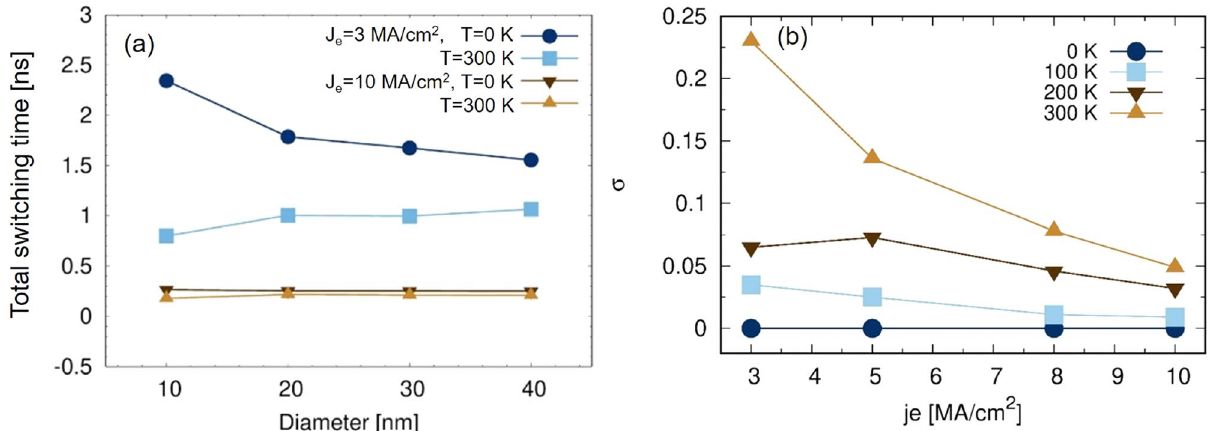
Figure 8. ( a ) Effect of finite size and temperature on the total switching time of magnetization in the free layer of CoFeB–MgO–CoFeB system by injecting the charge current density of 5 MA/cm 2 ( b ) the standard deviation of the calculated switching time as a function of current density for different finite temperatures for a MTJ diameter of 30